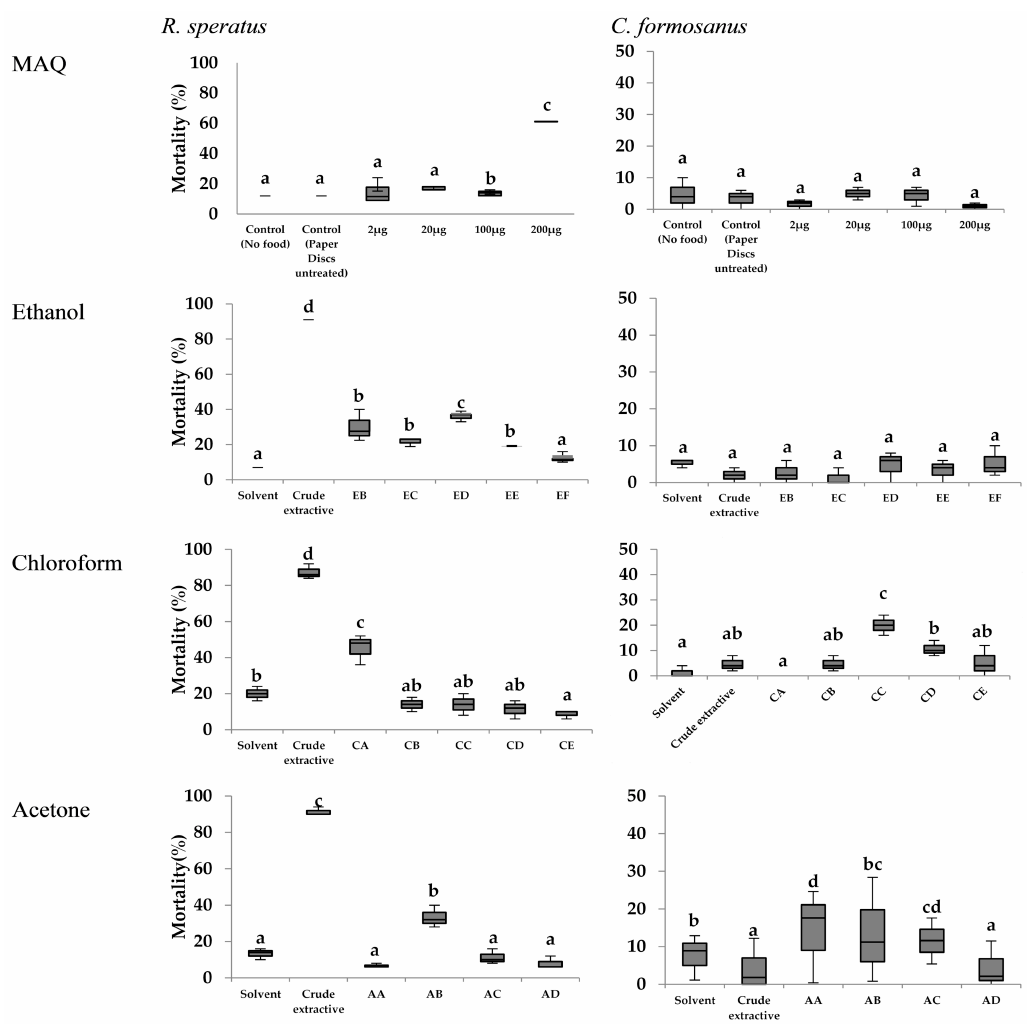
Figure 5. Box plot of the mortality observed for R. speratus and C. formosanus in no-choice feeding tests using fractions of T. grandis crude extractives and MAQ. Notes: Treatments with the same letters in the same graphic are not statistically different at p < 0.05, as determined by Duncan’s test; EB-EF, CA-